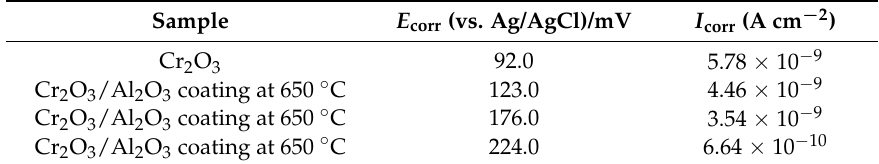
Figure 9. Potentiodynamic polarization curve of Cr 2 O 3 and Al 2 O 3 /Cr 2 O 3 composite coatings heat-treated at different temperatures. Table 1. Summary of the electrochemical parameters obtained from the potentiodynamic polarization curves for the unsealed and sealed coatings heat-treated at different temperatures.